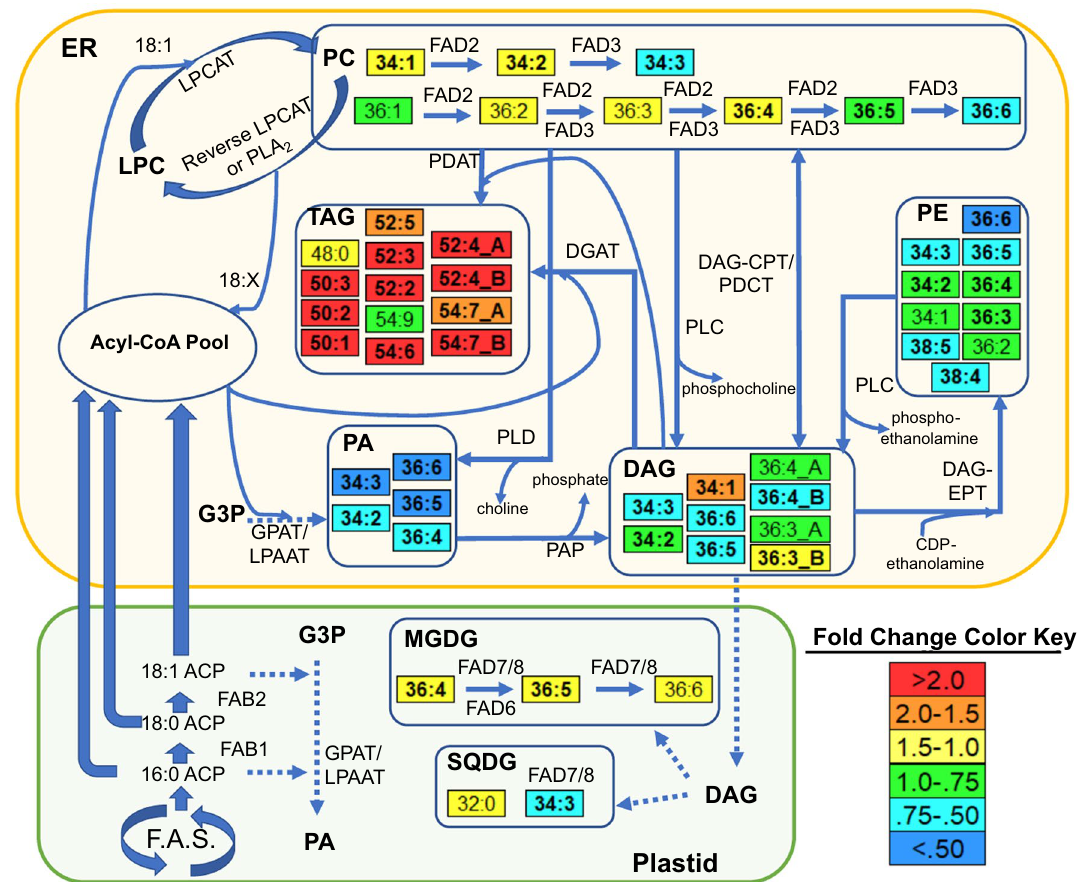
Figure 10. A lipid metabolic pathway map based on previously published information and results from the present study 14,23,24,59–62 . Dashed arrows indicate multi-step conversions. Lipid molecular species are identified as total acyl carbons: total double bonds. The fold change was calculated as the value of the lipid species under HT/the corresponding value under AT. Bolded lipids are significantly increased or decreased at α = 0.05 (Supplementary Table S3). ACP, acyl carrier protein; CoA, coenzyme A; DAG, diacylglycerol; DAG-CPT, CDP-choline:diacylglycerol cholinephosphotransferase; DAG-EPT,